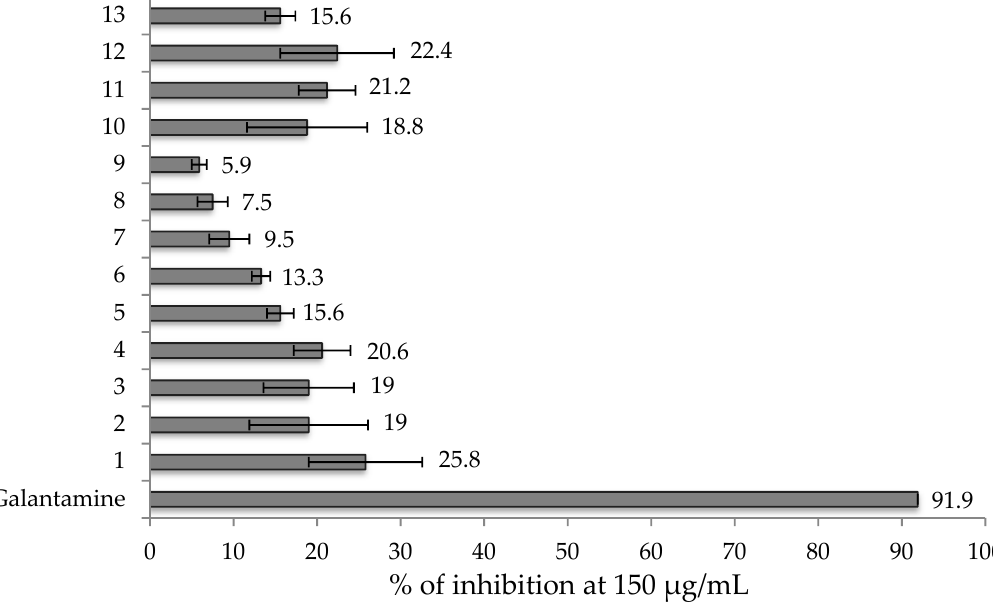
Figure 1. Percentage of acetylcholinesterase inhibition of triphenyl imidazole compounds 1–13 (150 μ g/mL). Galantamine served as the reference compound.